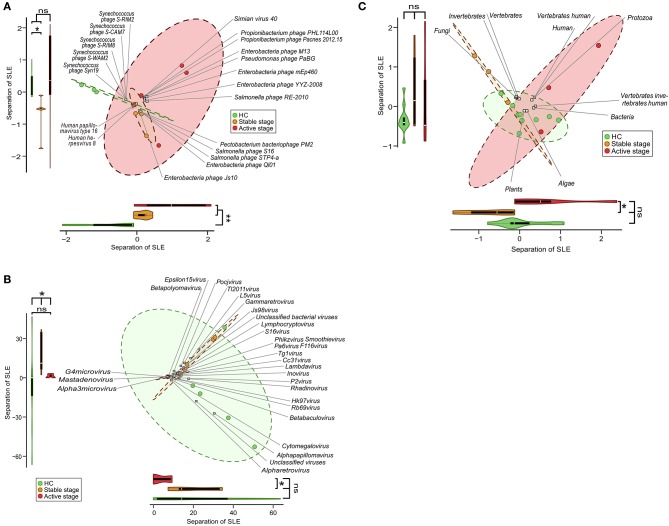
Clinical stage-associated dysbiosis of the peripheral blood mononuclear cell (PBMC) virome in systemic lupus erythematosus (SLE). Biplot summarizing the redundancy analysis (dbRDA) of virome profiles at species- (A), genus- (B), and host-levels (C). Projection axes were assessed individually by Wilcoxon's rank-sum tests. ns, no significant difference; *P < 0.05; **P < 0.01.